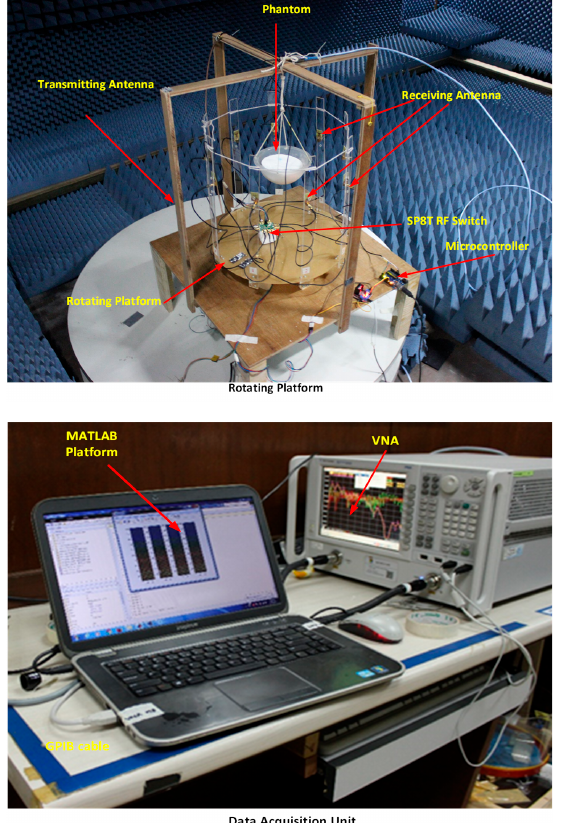
Figure 14. Experimental setup of imaging system.